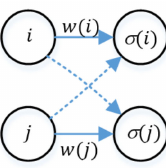
Figure 17. The alternative graph depicts a partial system with two operations i and j that cannot be processed at the same time.